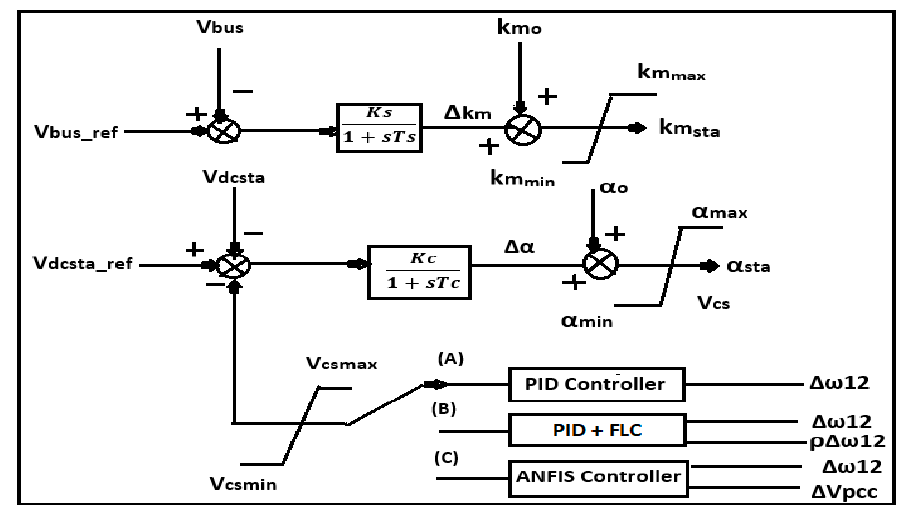
Figure 4. Static synchronous compensator (STATCOM) control unit employing the PID, hybrid PID and Fuzzy Logic Controller (FLC) and adaptive network-based fuzzy inference system (ANFIS) damping controllers.